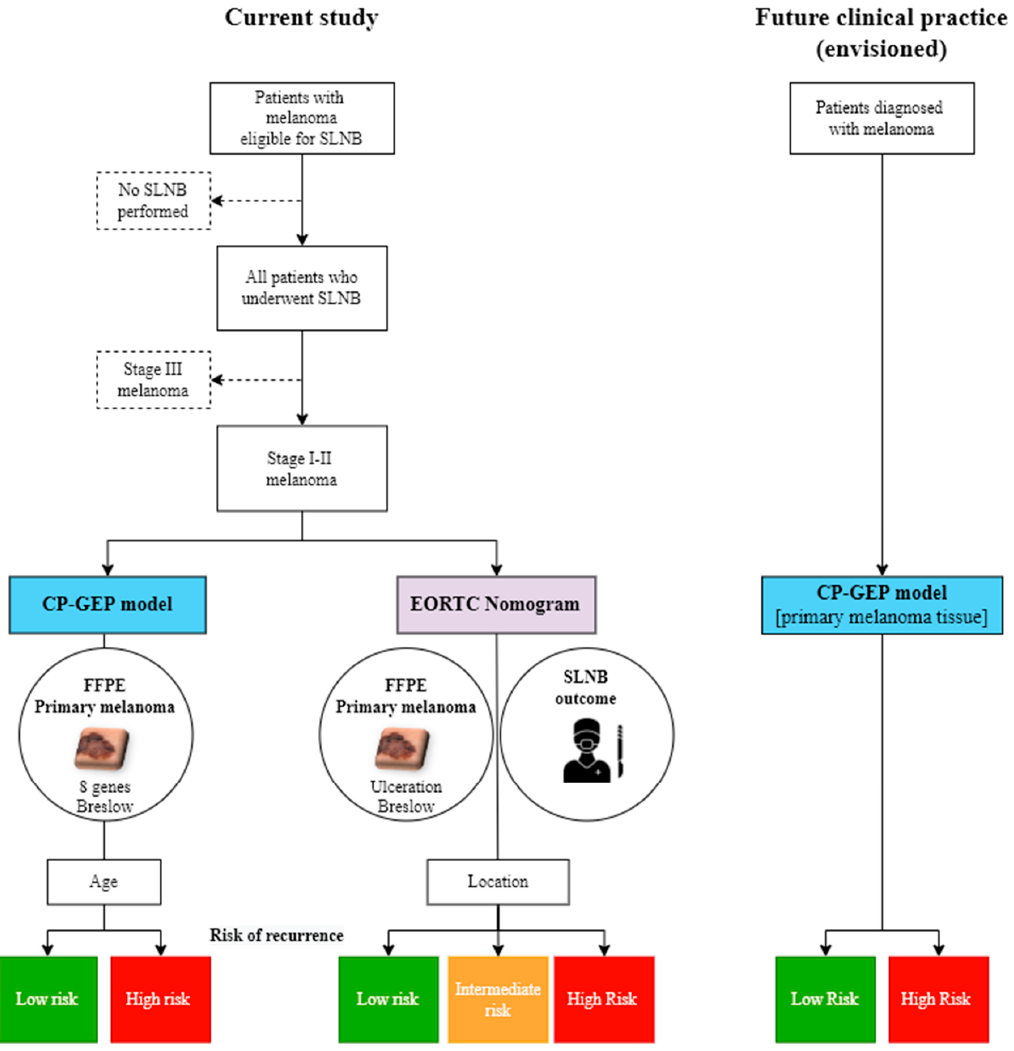
Figure 3. Differences in envisioned clinical practice using CP-GEP versus EORTC nomogram to predict risk of recurrence. For the application of the CP-GEP model, only tissue from the (already excised) primary melanoma is needed (in combination with Breslow depth in mm and patients’ age at diagnosis). For the EORTC nomogram, an SLNB is required. CP-GEP, clinicopathologic and gene expression profile; EORTC, European Organization for Research and Treatment of Cancer; FFPE, formalin-fixed paraffin-embedded; SLNB, sentinel lymph node biopsy; SN, sentinel